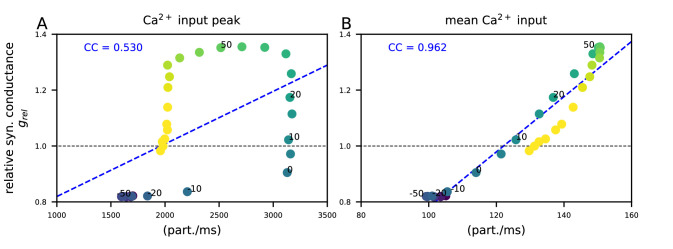
The post-STDP synaptic conductance is weakly correlated with the peak of the Ca2+ input but strongly correlated with the mean Ca2+ input during the inter-stimulus interval.The y-axis shows the post-STDP synaptic conductance (in presence of β-adrenergic and cholinergic neuromodulation) relative to baseline as in Figure 5M. (A) The x-axis shows the peak Ca2+ input (in particles/ms) for different ISIs (see Figure 5D–F and Figure 5—figure supplement 1E). (B) The x-axis shows the time integral of Ca2+ input of Figure 5D–F from −500 to 500 ms, normalized by 1000 ms (see Figure 5—figure supplement 1F). Different colours represent different ISIs between −200 and 200 ms (intervals 0,±10,±20, and ±50 labeled for reference). The blue dashed line shows the linear regression, and the blue text shows the corresponding Pearson correlation coefficient.